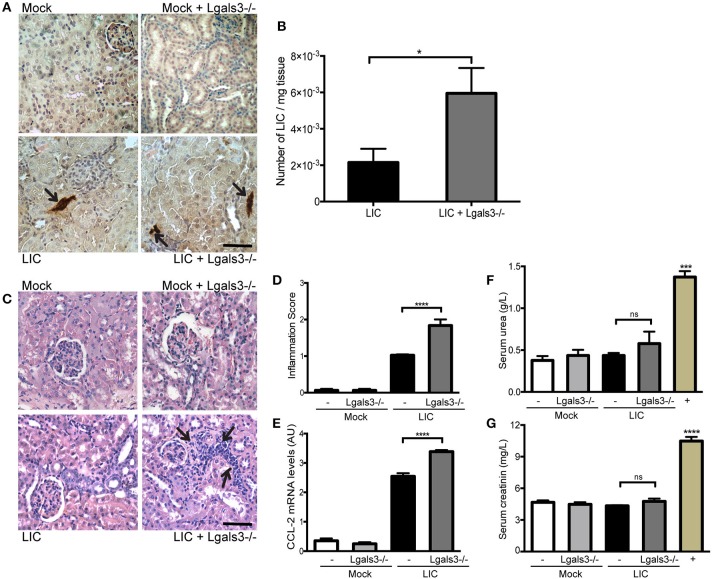
Genetic disruption of Gal-3 significantly increased the acute bacterial burden and acute kidney inflammation. (A) Immunostaining with an antibody against LipL32 (the major Leptospira interrogans antigen) in kidney sections of Mock, Mock + Lgals3−/−, LIC and LIC + Lgals3−/− groups of mice at 14 days post-infection (dpi). (B) Absence of galectin-3 in LIC-infected mice resulted in higher bacterial load in kidneys compared to wild-type LIC group. β-actin was used as a housekeeping control. (C–E) Representative haematoxylin-eosin staining of kidney sections. An inflammation score was established by a pathologist and CCL-2 mRNA was quantified by qRT-PCR as a molecular marker of inflammation; β-actin was used as a housekeeping control. Acute kidney inflammation as well as significantly higher CCL-2 levels were detected in LIC + Lgals3−/− group. (F,G) Normal urea and creatinine levels in serum samples from all experimental groups were detected and assayed as a measure of renal functions at 14 dpi. Serum samples from LIC-infected gerbils were used as a positive control (+). In all cases, data represent assays of two independent experiments of groups of 6 animals, each. Bars indicate 50 microns; AU, arbitrary units; nsP > 0.05; *P < 0.05; ***P < 0.001; ****P < 0.0001.